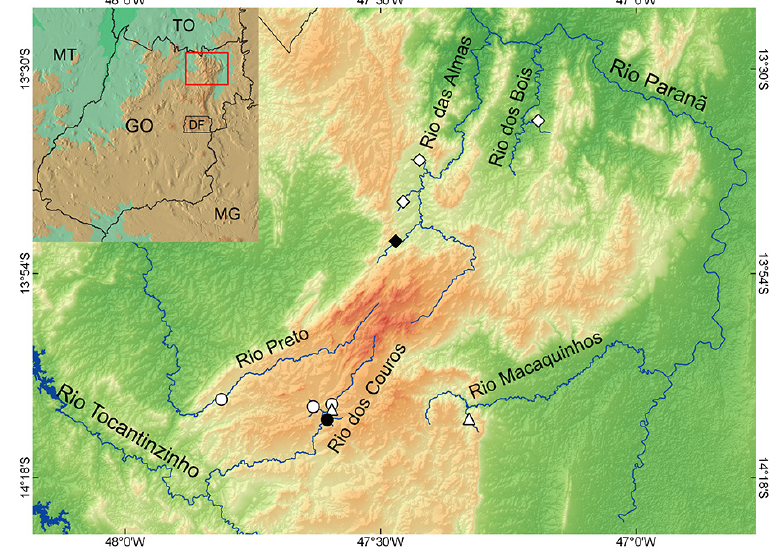
FIGURE 7 | Map of the Chapada dos Veadeiros indicating the known distribution of Characidium : circles represent Characidium kalunga , triangles, C. xanthopterum , and diamonds, C. stigmosum . Black symbols indicate the type locality and white symbols other